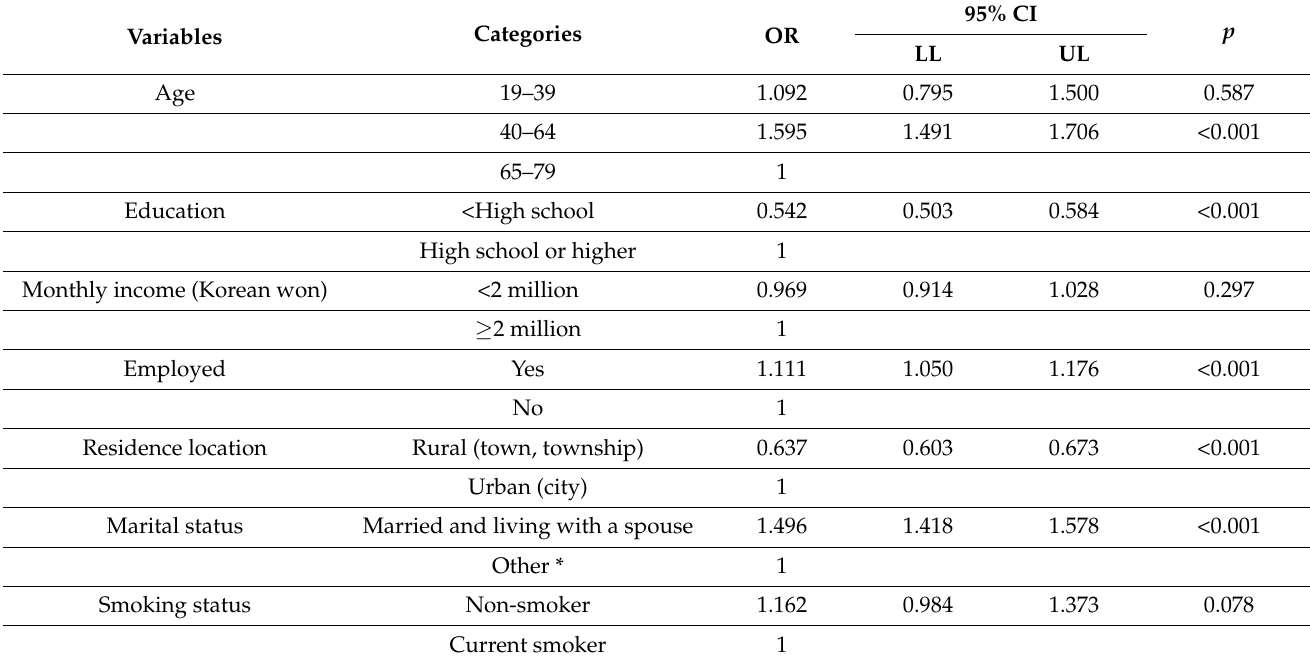
Table 4. Factors associated with blood pressure level